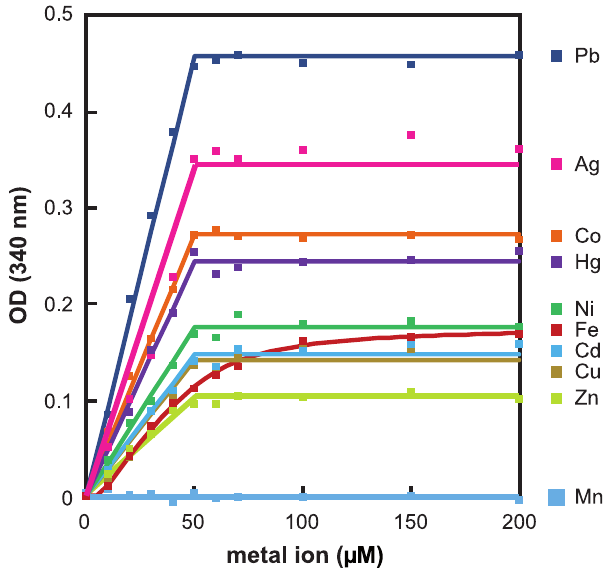
Figure 2. Formation of metal-selenide colloids. To monitor the formation of metal-selenide colloids, mixtures containing sodium selenide (50 m M) and the indicated metal salt concentrations were prepared inside an anaerobic glove box. After 10 min incubation at room temperature (180 min in the case of iron), the optical densities of the solution were measured at 340 nm. In the cases of cadmium, cobalt, copper, mercury, nickel, lead, silver and zinc, data were fitted to a one- site binding equation (least square minimization) assuming that the affinities between the constituents involved in complex formation were infinitely high. In the case of iron, data were fitted to the solubility product equation ([Fe 2 + ][Se 2– ]=K sp ). Obtained pK sp value was 18.5 6 0.2. Manganese, magnesium and calcium did not modify the optical density of the sodium selenide solution. Data with manganese are shown as an